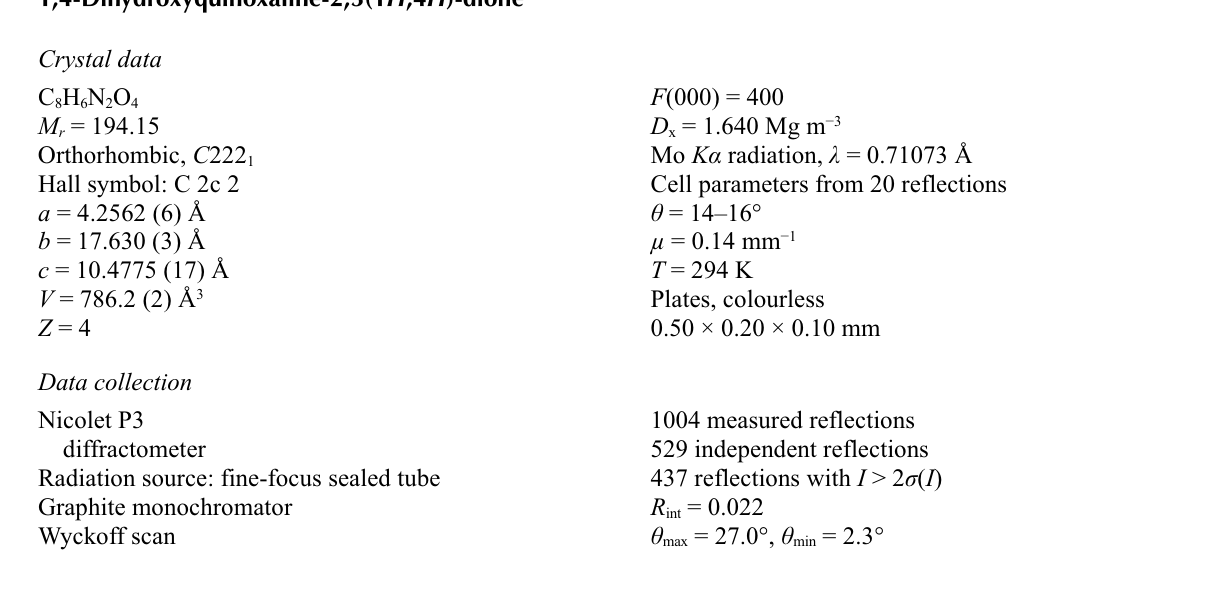
A packing diagram of (I), showing the layers of molecules parallel to c axis. All hydrogen atoms were omitted for clarity. Hydrogen bonds are shown as dashed lines [symmetry codes: (i) - x , y , - z + 1/2, (ii) x , - y + 1, - z ]. 1,4-Dihydroxyquinoxaline-2,3(1 H ,4 H